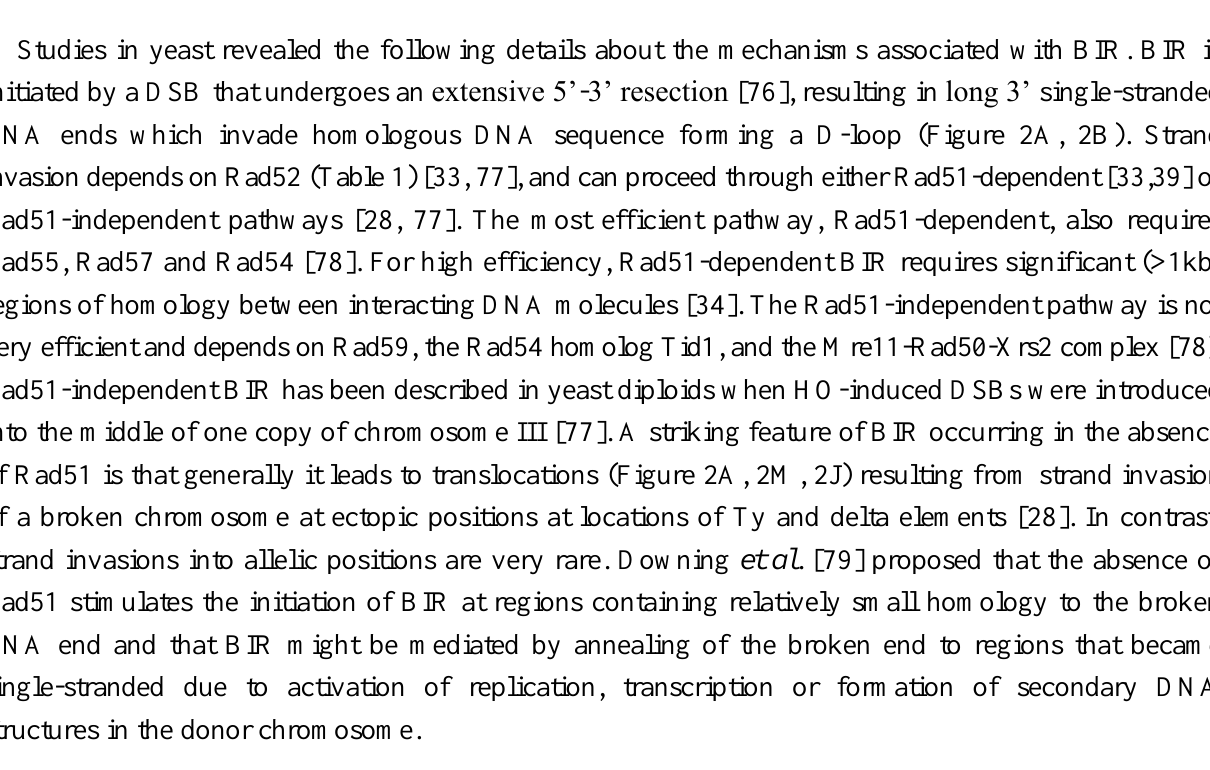
Table 1. Requirements for recombination and replication proteins in Gap Repair (Gene Conversion) and BIR in